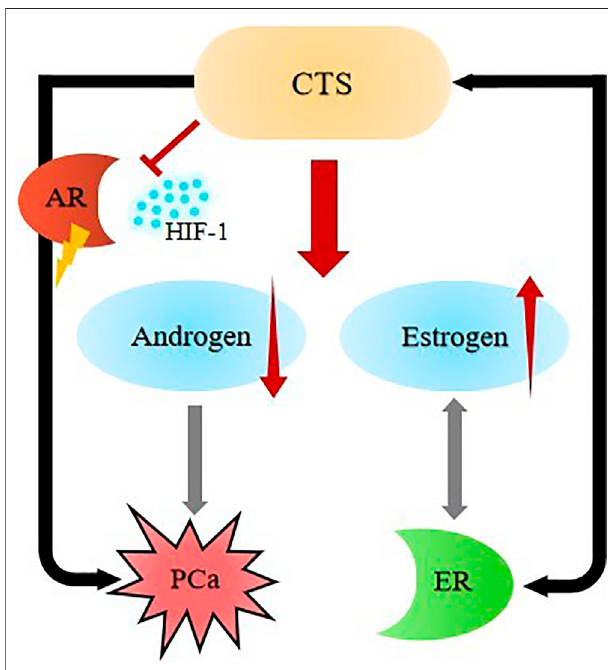
FIGURE 4 | Biological activity of CTS in